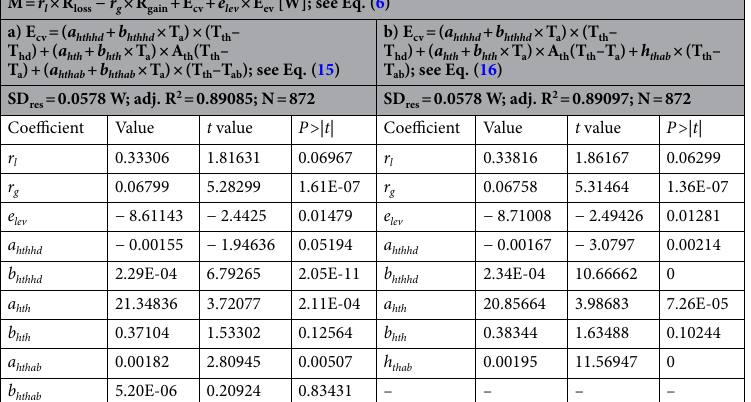
M = r l × R loss − r g × R gain + E cv + e lev × E ev [W]; see Eq.